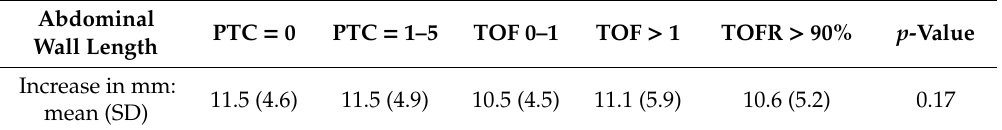
Table 4. Measurement of the increase in abdominal wall